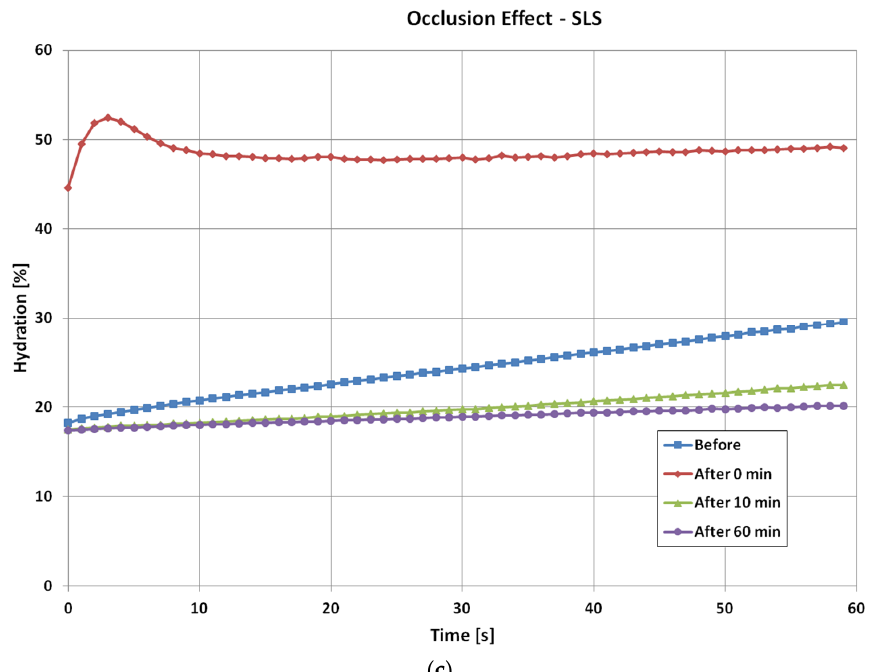
Figure 4. The time dependent skin hydration occlusion curses before and after the intensive wash ( a ); tape stripping ( b ); SLS irritation ( c ).